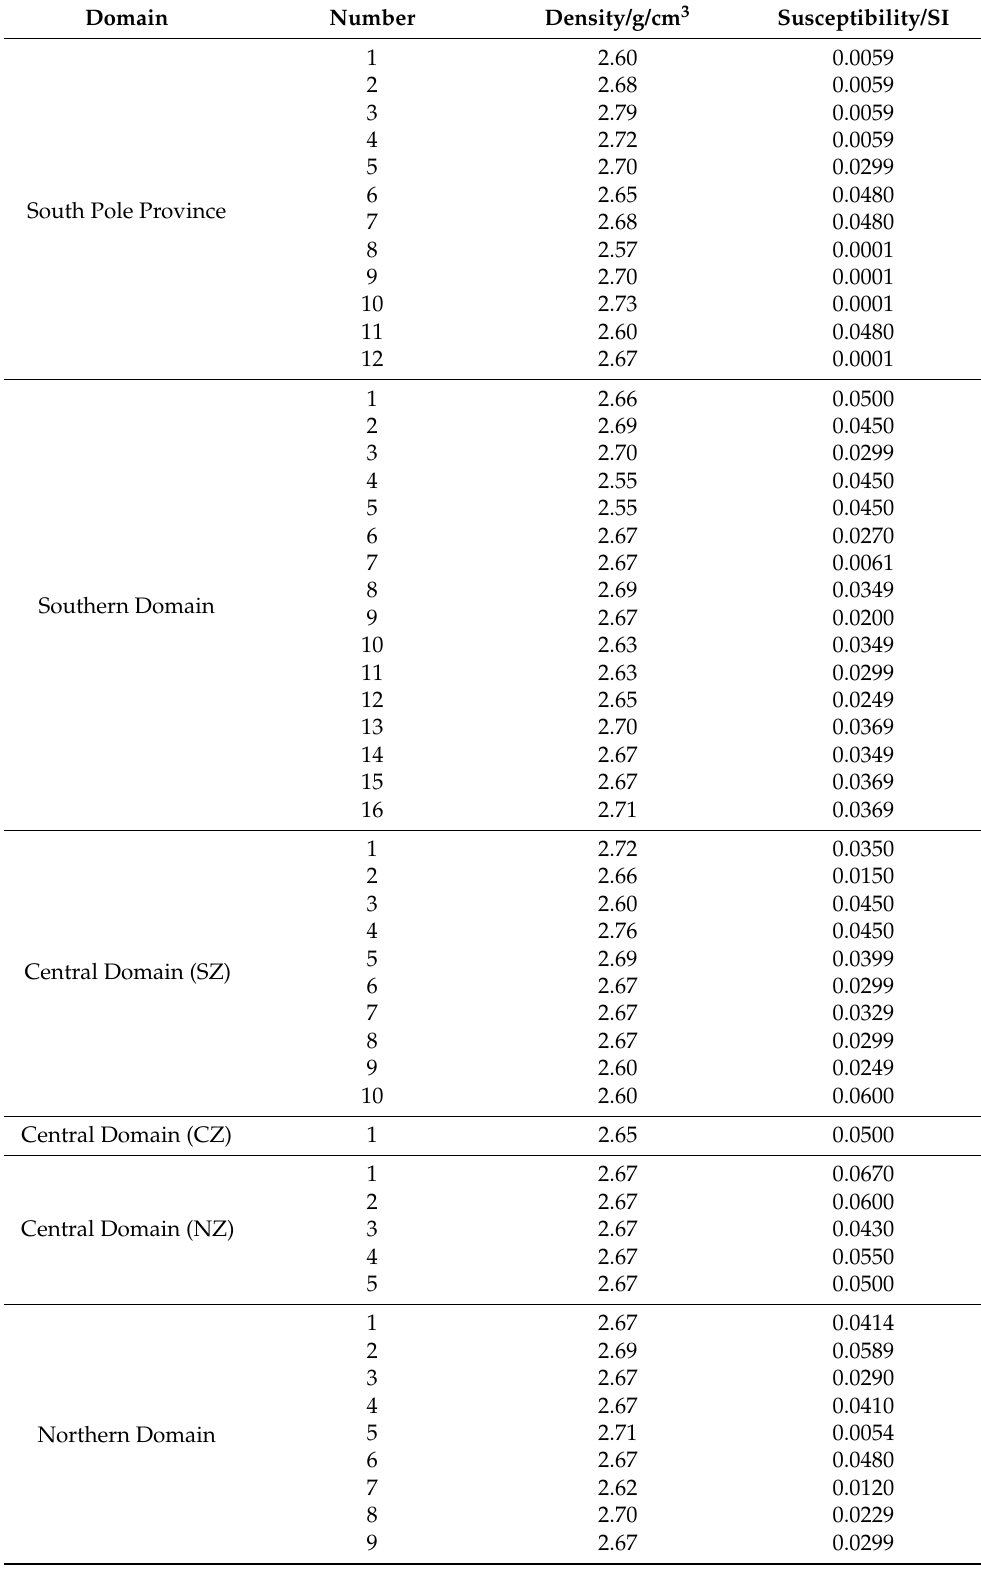
Table A1. Density and magnetic susceptibility settings of the gravity and magnetic